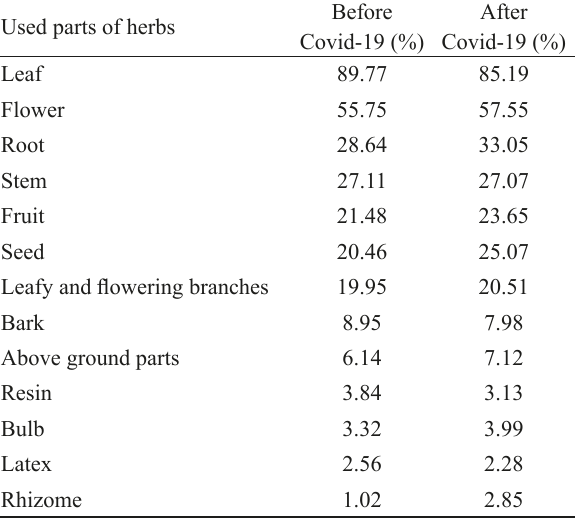
Table 1. Used parts of herbs.